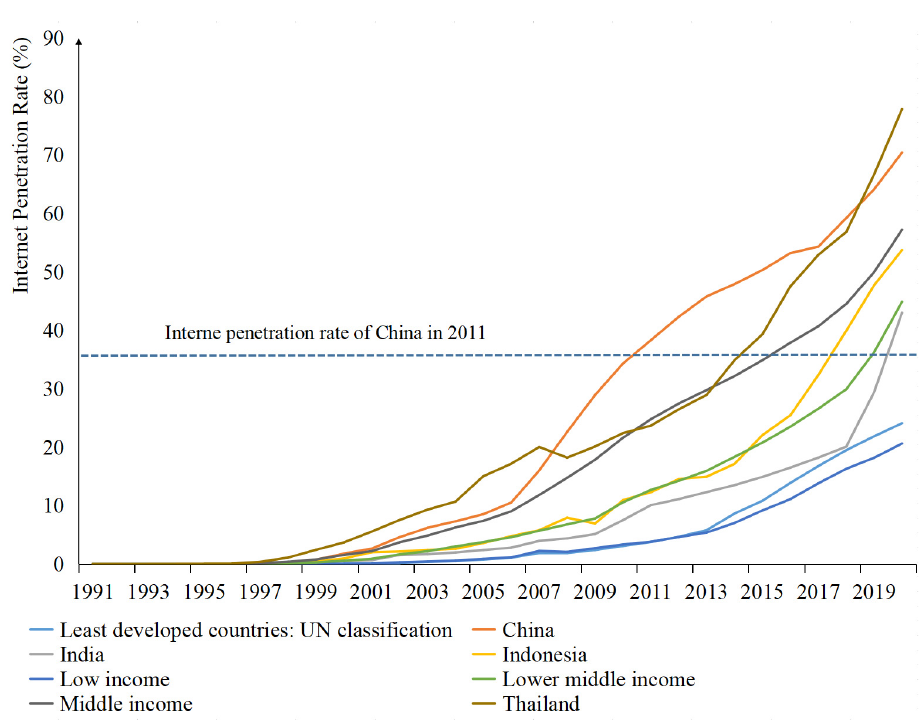
Figure A1. Internet penetration rate in some countries (regions) from 1991–2020. Source : World Bank database, https://data.worldbank.org/indicator/IT.NET.USER.ZS (accessed on 1 March 2022).